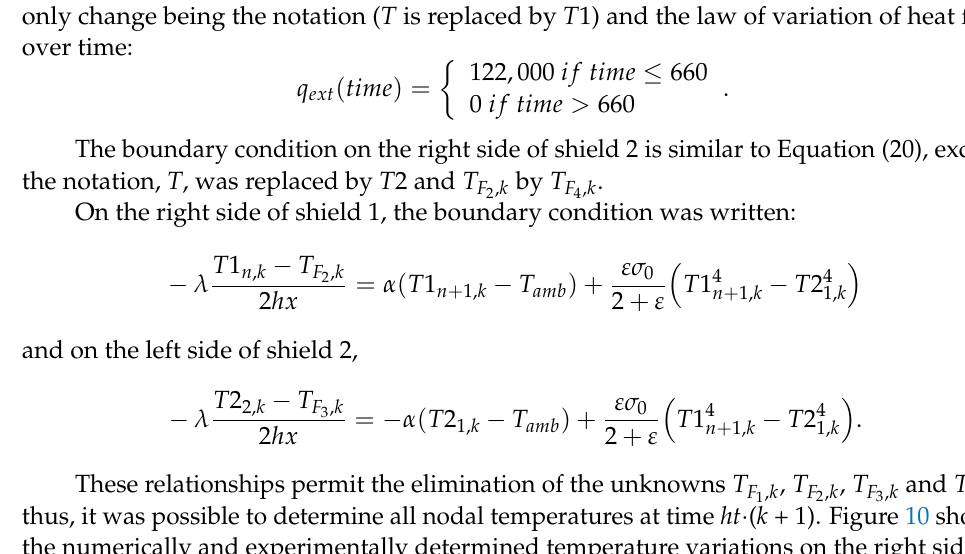
Figure 9. Discretization with nodes for the second experiment.